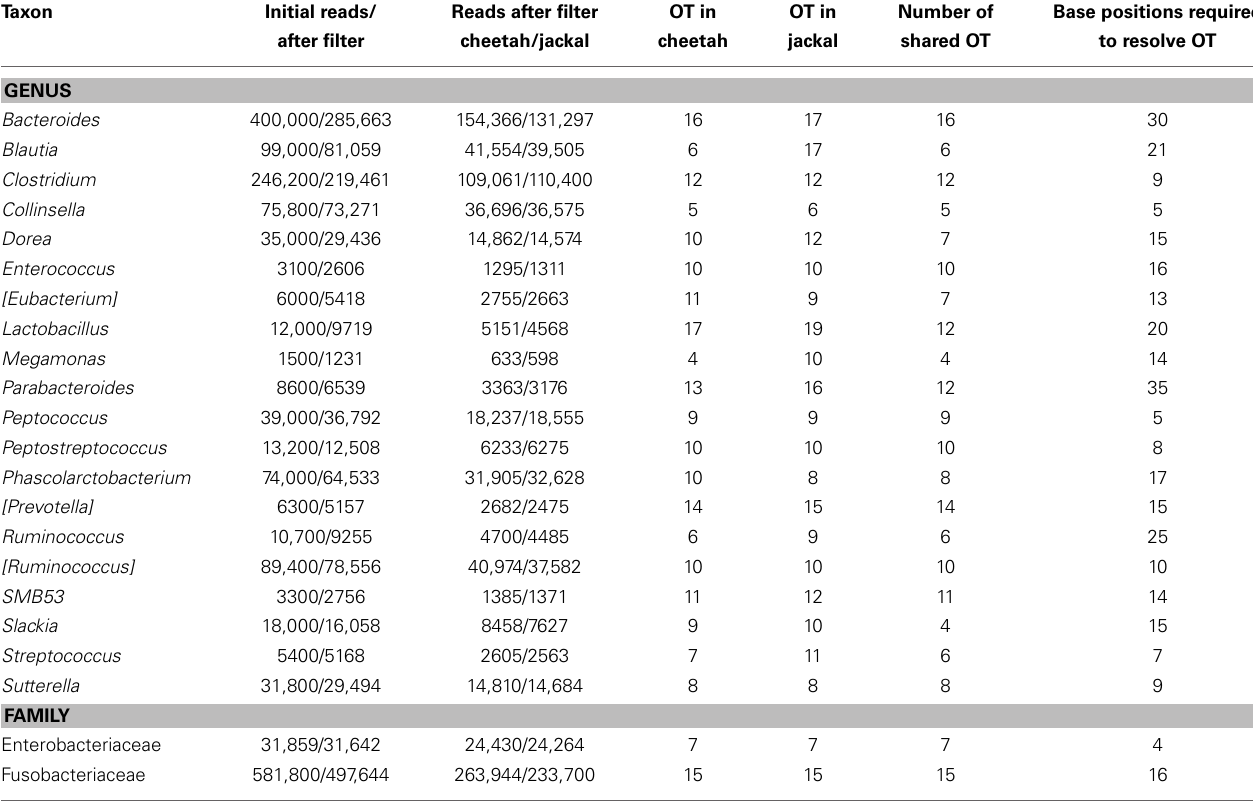
Table 2 | Oligotyping results for the cheetah and the black-backed jackal for shared bacterial genera and families. Taxon